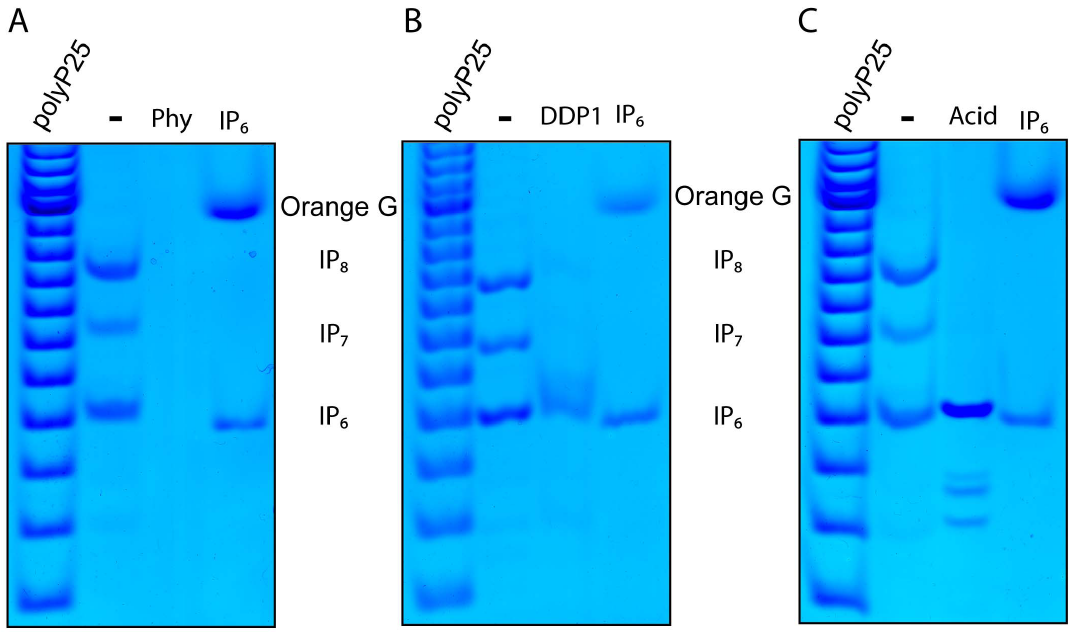
Figure 2. Treatment by Phytase , Ddp1 and acidic degradation define IP 6 , IP 7 , and IP 8 , in D.discoideum cell extract. Wild type D. discoideum cell extract (-) was incubated with phytase (Phy) (A), recombinant diphosphoinositol polyphosphate phosphohydrolase (DDP1) (B) or treated with acid at high temperature (C). The inositol phosphate nature of the three major bands detectable by Toluidine stain is demonstrated by the Phytase treatment (A), an enzyme able to remove the phosphate group from any position of the inositol rings. The pyrophosphate nature of the two slower migrating bands is demonstrated by their disappearance after DDP1 treatment (B) and by the well known acidic sensitivity of the phosphoanhydride bond (C). The figure shows the result of a representative experiments repeated three to four times.